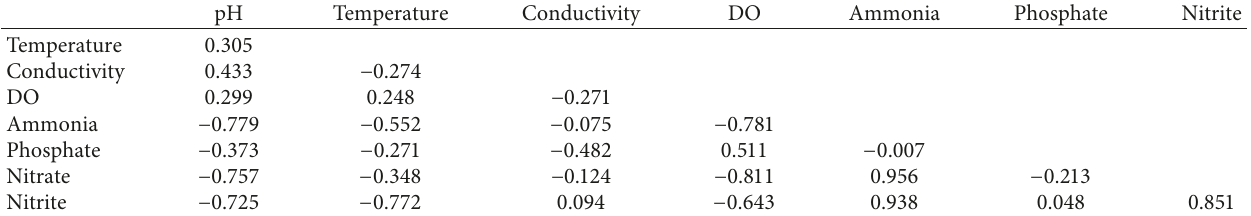
Table 1: Pearson’s correlation coefficient for surface water quality parameters.